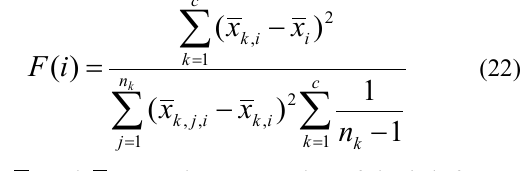
Figure 5. Activation function plots. (a) Sigmoid; (b)